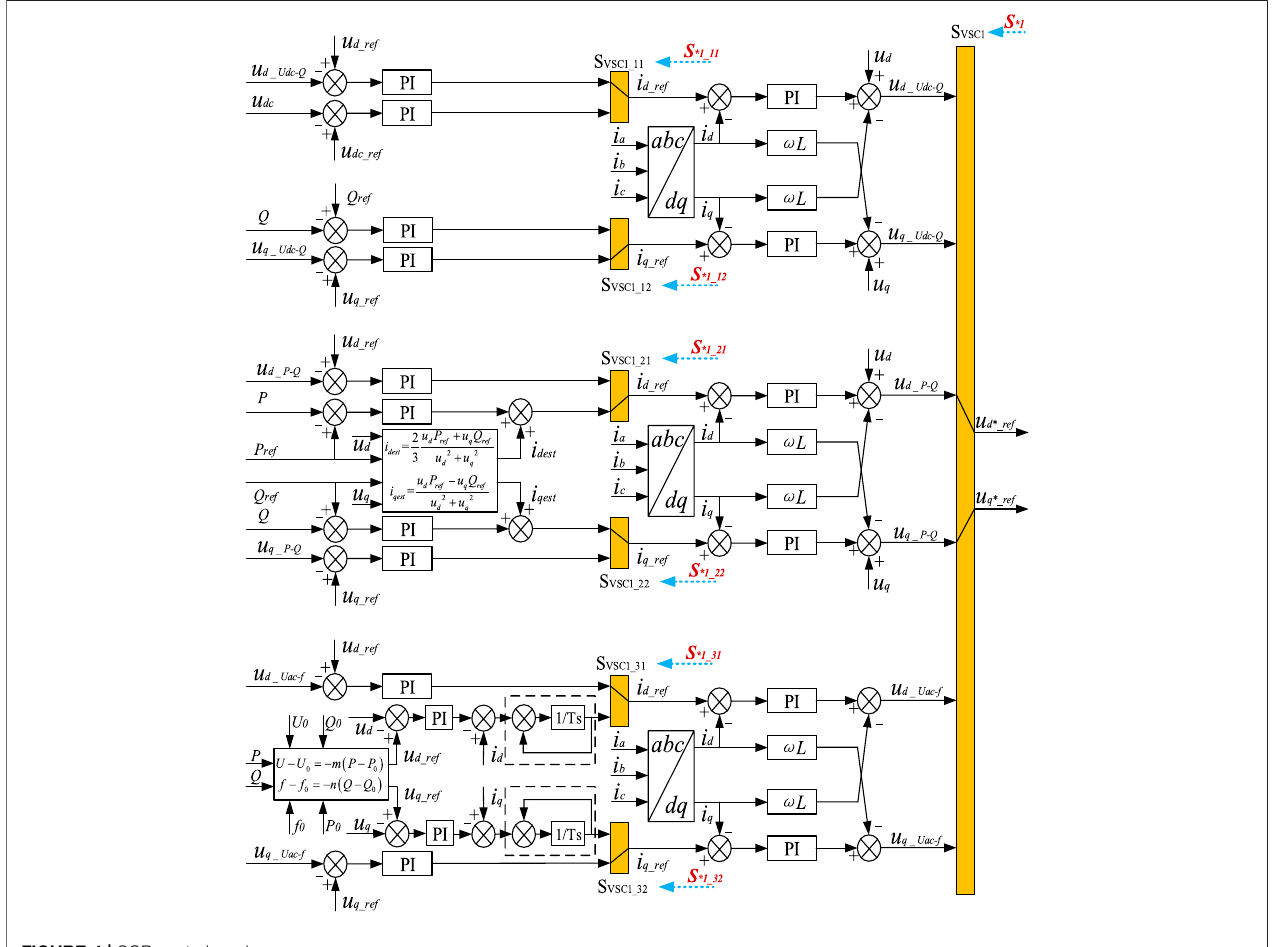
FIGURE 4 | SOP control